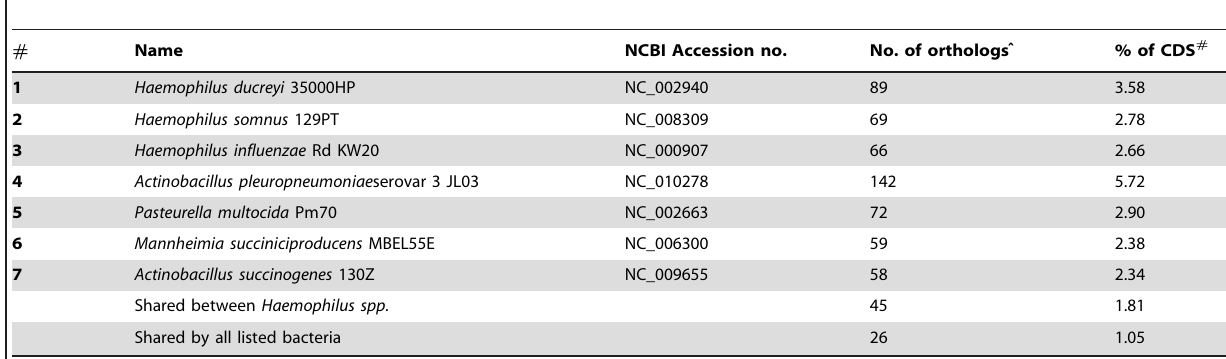
Table 2. Potential strain ZJ0906 orthologs found in complete genomes of other